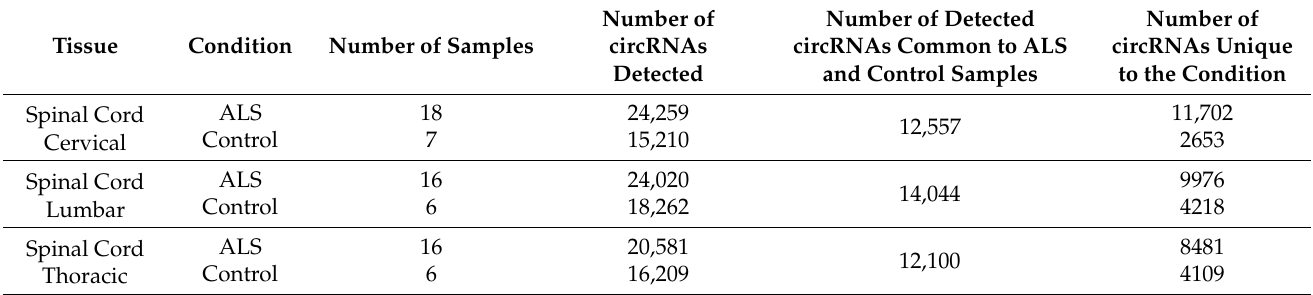
Table 1. Average number of circRNAs detected in different sample types in different